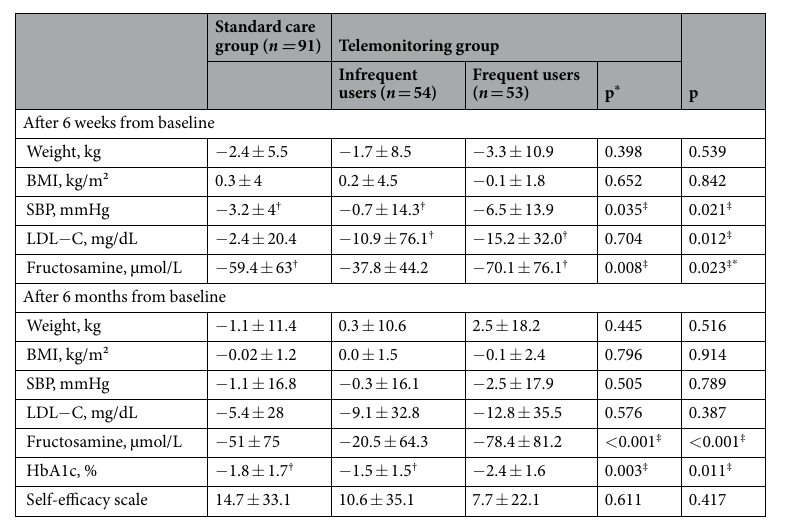
Table 2. Changes from baseline to 6 weeks and 6 months among the groups. Data are expressed as the mean ± SD. * p value between the telemonitoring group. † No differences between the groups with same superscript symbols in post-hoc analyses. ‡ p <